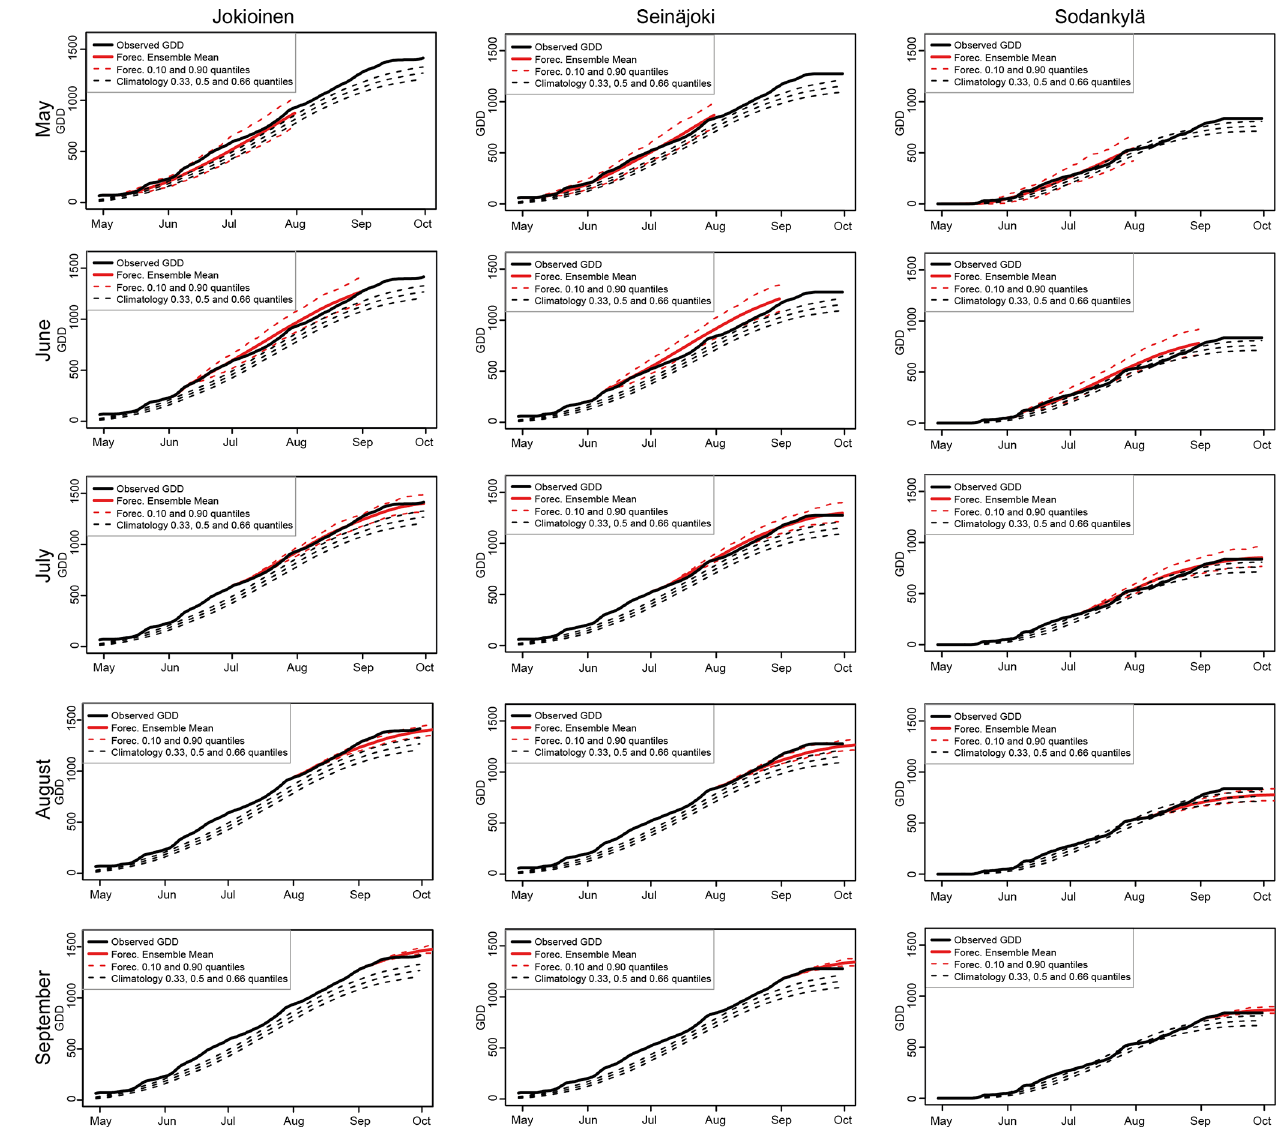
Figure 4. Forecasted and observed GDD during May–September 2019 for the selected locations: Jokioinen, Seinäjoki and Sodankylä. Runs from October are not included in the figure since growing season ended during